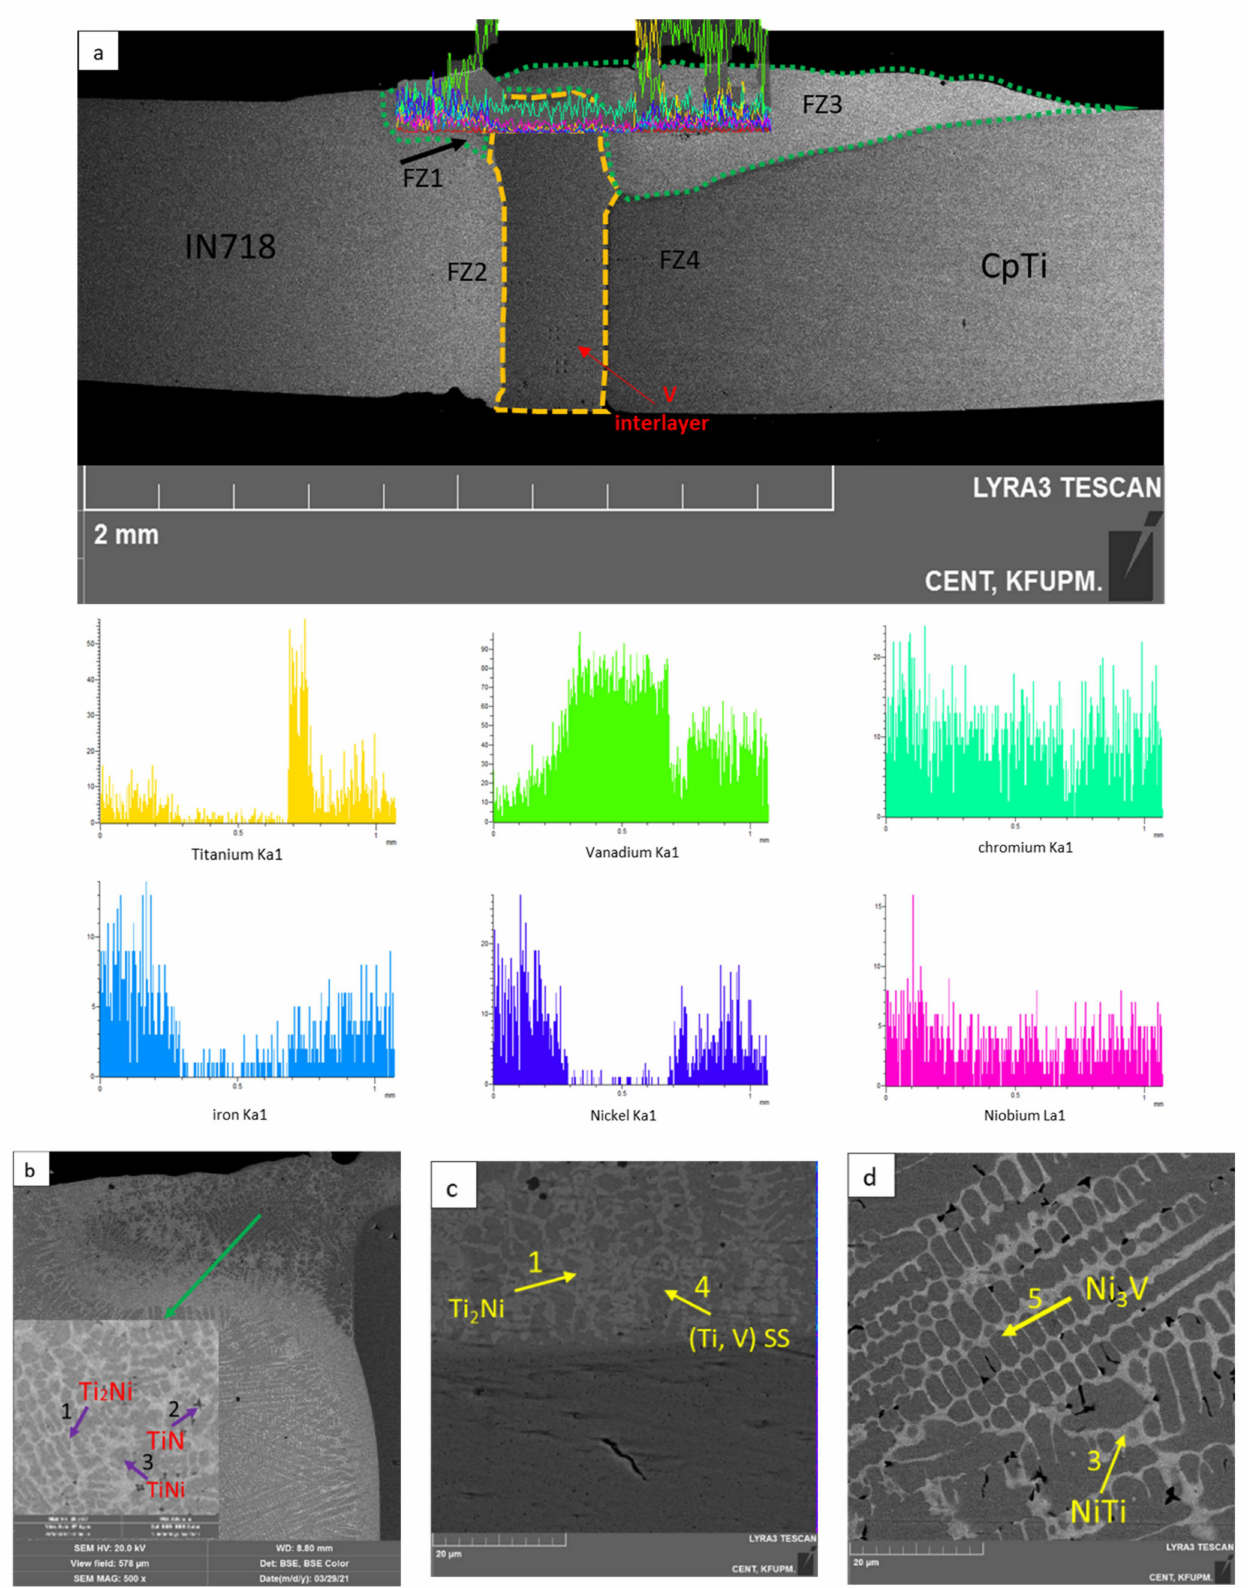
Figure 2. ( a ) SEM micrographs of the CpTi/V/IN718 joint with EDS line scan. Microstructures in the common melt zone of all three materials in the arc facing side: ( b ) Inconel 718 side; ( c ) region right above the V interlayer; and ( d ) the CpTi